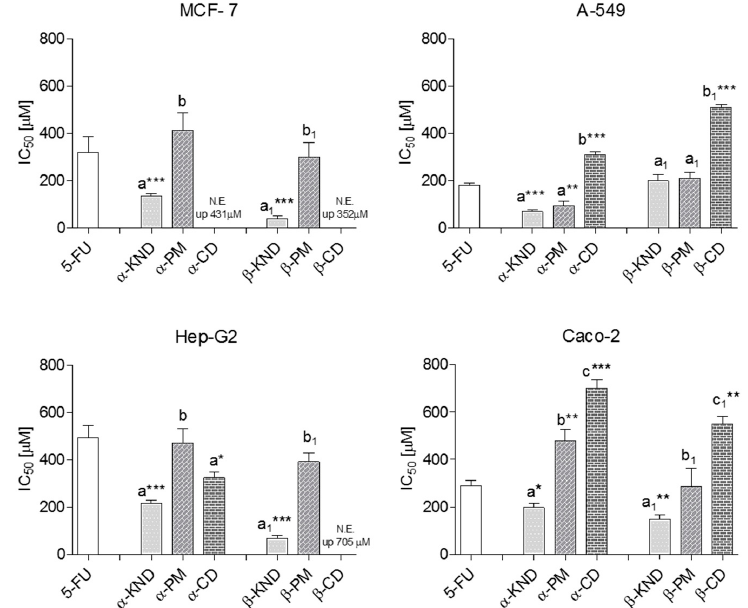
Figure 12. Cytotoxic activity expressed as IC 50 (µM) of 5-FU, α -KND and β -KND, α -PM and β -PM, α -CD and β -CD against MCF-, A-549, Hep-G2, and Caco-2 cell lines. Significant differences from 5-FU highlighted by asterisks (Dunnett’s test—* p < 0.05; ** p < 0.01; *** p < 0.0001). Different letters mean significant differences for p < 0.05 among samples tested (Tukey’s HSD multiple comparison test).